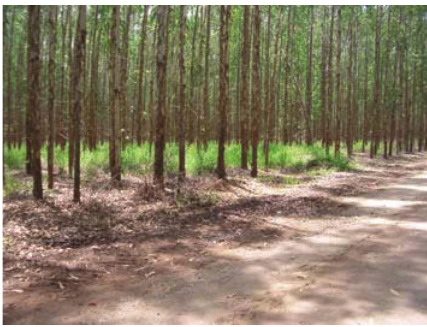
Figure 5: Evidence of hydrologically sensitive area being occupied by the former Eucalyptus plantation in the study catchment.